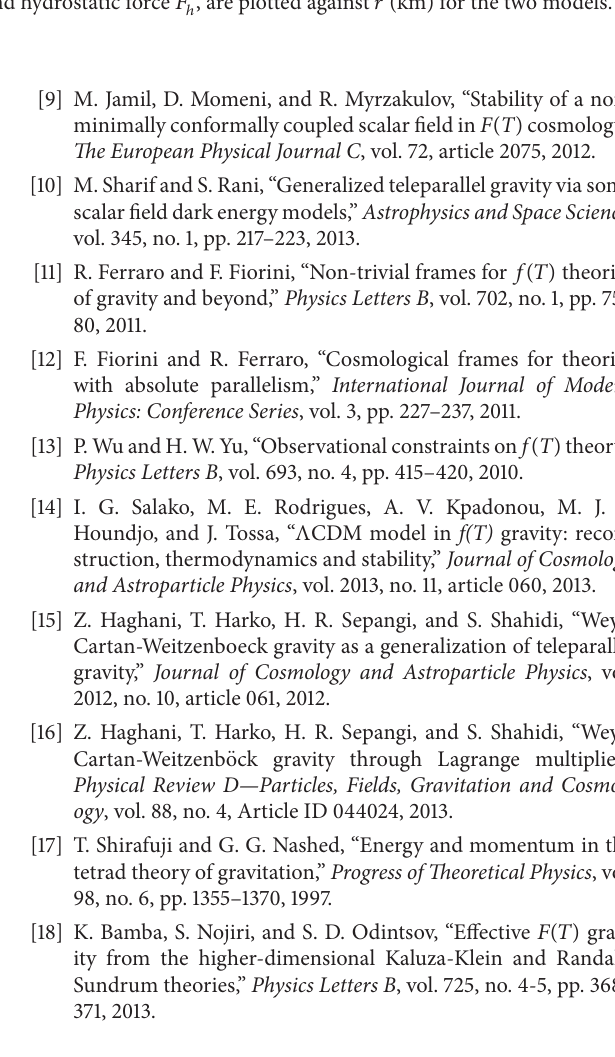
Figure 5: The two different forces, that is, gravitational force 𝐹 𝑔 and hydrostatic force 𝐹 ℎ , are plotted against 𝑟 (km) for the two